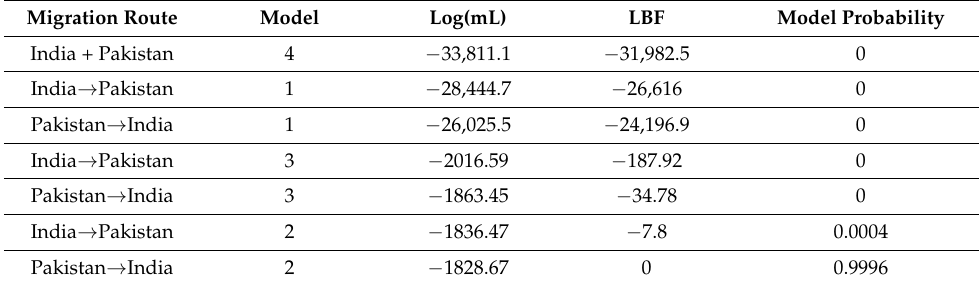
Table 2. Level one population movements, India + Pakistan, India → Pakistan, Pakistan → India. The order of the models in each route was according to log marginal likelihood and the Bayes factor, the lowest to the highest. Log(mL), log marginal likelihood, LBF Bayes